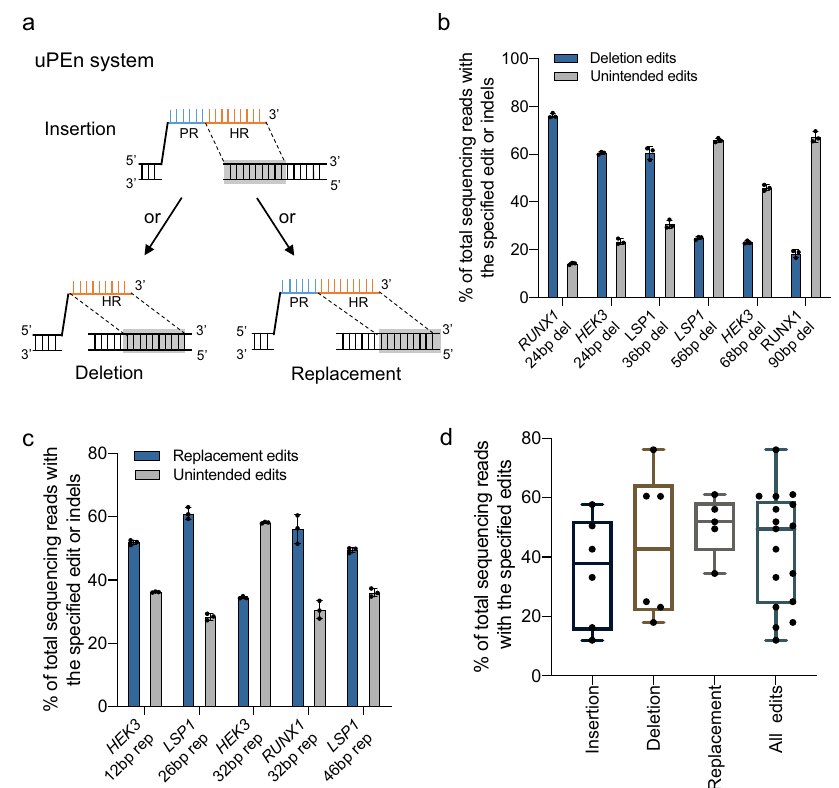
Fig.3|TheuPEnmediatedmoreef fi cientprimeeditingforinsertions,deletions andsequencereplacements.a Schematicdiagramillustratingdesignsandvarious types of edits (insertions, deletions or replacements) generated by the uPEn sys- tem. PR, programmed region (blue); HR, homologous region (orange). Gray fi ll indicates the base-pairing with the genomic sequence. b Deletional edits of dif- ferent sequences with uPEn (in the uPEn3 format, same throughout this fi gure) at multiple sites in HEK293T cells. Values and error bars re fl ect the mean and s.d. of three biological replicates. c Sequence replacement type of edits with uPEn at